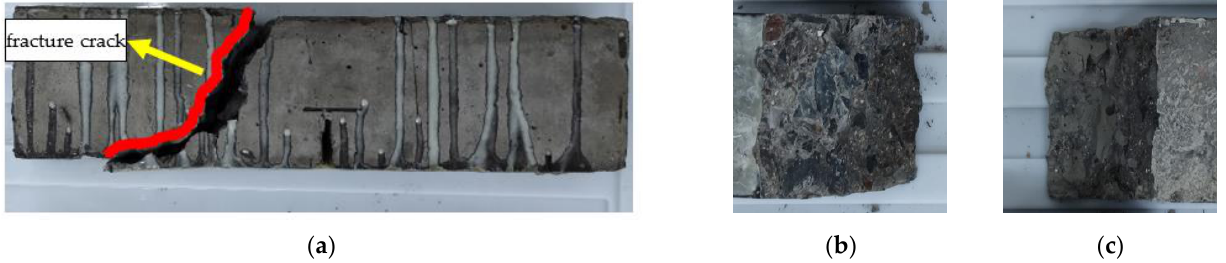
Figure 25. Failure mode of RFSI-400: ( a ) side surface; ( b ) fracture surface 1; and ( c ) fracture surface 2.